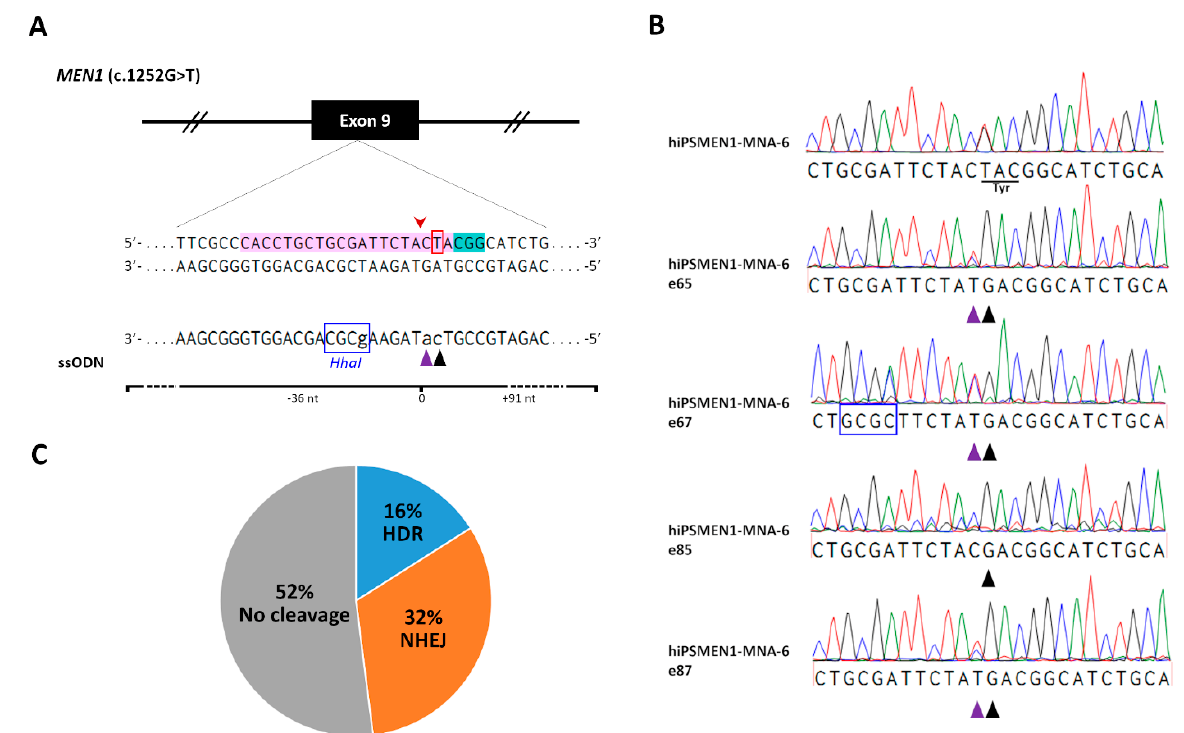
Figure 3. CRISPR/Cas9-mediated correction of the c.1252G>T in the MEN1 gene in patient-specific iPSCs. ( A ) Schematic representation of the mutated region of MEN1 with the corresponding ssODN repair template. The magnified view illustrates the sgRNA target site (shown in magenta) and the PAM sequence (shown in cyan) in the MEN1 gene. The mutated nucleotide (thymidine) is labeled with a red open box. The potential Cas9 cleavage site is indicated by a red arrowhead. Three intended point mutations in the ssODN are indicated by lowercase letters, where Cas9-blocking mutation and the desired mutation (cytosine) are indicated with a purple and a black triangle, respectively. The HhaI restriction site is labeled with a blue open box; ( B ) Sequencing chromatograms of patient-specific hiPSMEN1-MNA-6 cells harboring heterozygous mutated alleles of MEN1 and successfully edited clones (e65, e67, e85, e87) with wild-type repaired alleles. The potential Cas9 cleavage site is indicated by a red arrowhead. The tyrosine (mutated) and the aspartic acid (wild-type) codons are underlined. The triangles indicate Cas9-blocking mutation (purple) and the desired nucleotide change (black). The HhaI restriction site is labeled with a blue open box. Clone hiPSMEN1-MNA-6-e67 contains all three desired mutations; ( C ) A pie chart shows the pattern of CRISPR-Cas9-induced modifications of MEN1 in patient-specific iPSCs. HDR—precision editing by homology-directed repair, NHEJ—deletions caused by non-homologous end joining.